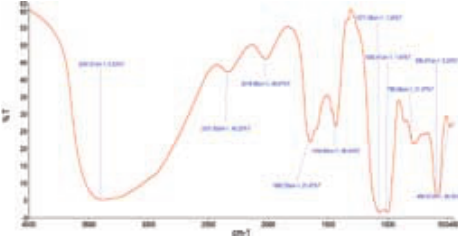
Figure 5: Infrared spectrum from goat A showing struvite bands at 3401, 1440, 1670 and 995.16 cm -1